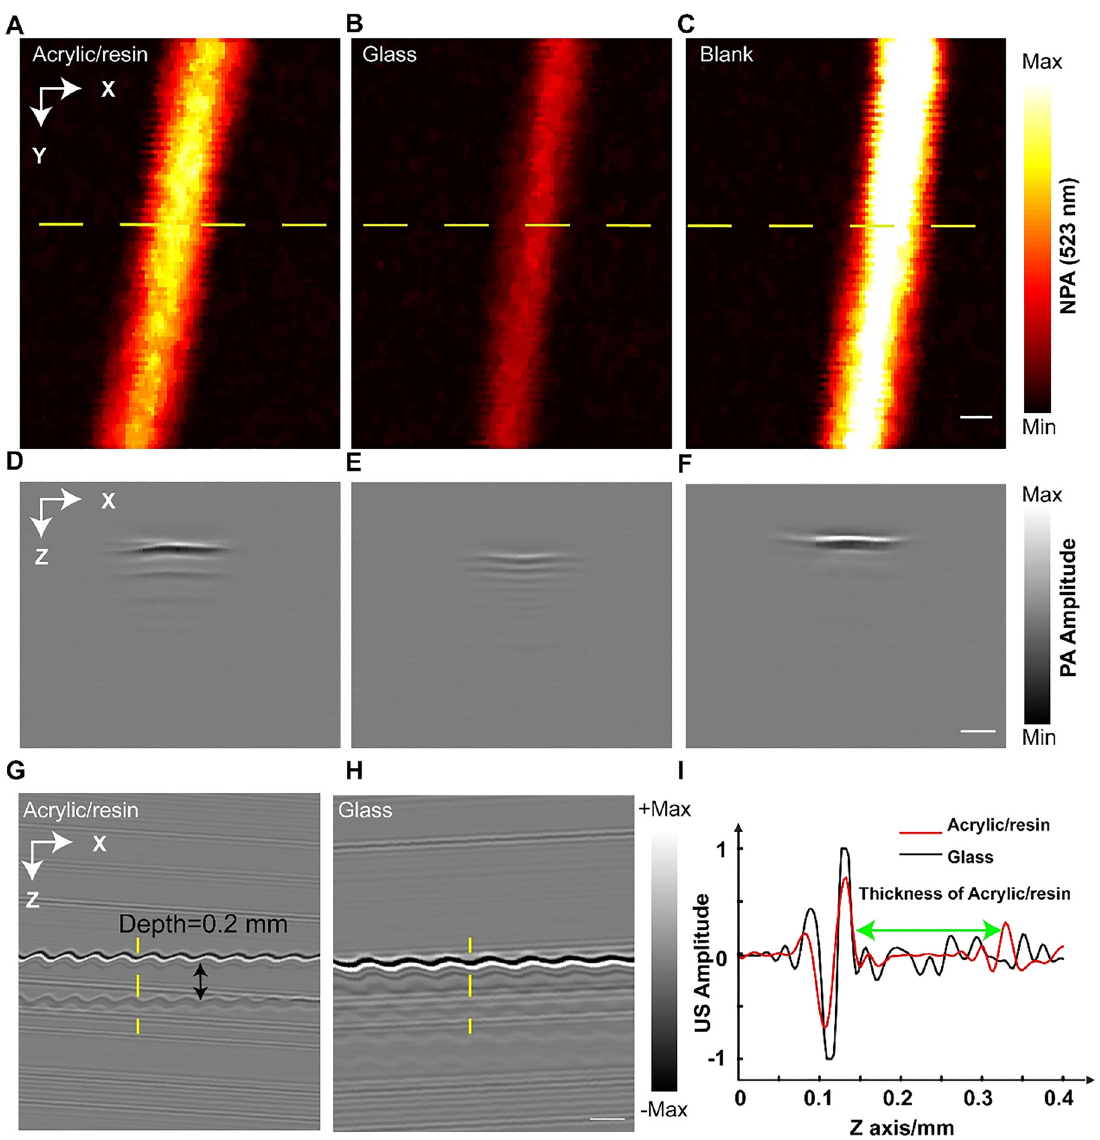
Figure 4: The photoacoustic imaging and ultrasound imaging of acrylic/resin and glass coverslips. (A – C) Photoacoustic maximum amplitude projection (MAP) imaging of a hair covered by the acrylic/resin and glass coverslips. NPA represented normalizedphotoacoustic. Scale bar:100 µm.(D – F) Cross-sectional images in the XZ plane corresponding to positionsindicated by the yellow dashed lines in A – C. Scale bar: 200 µm. (G – H) Ultrasonic cross-sectional images of the acrylic/resin and glass coverslips in the XZ plane. (I) Ultrasonic signal pro fi le through the yellow dashed lines in G – H. Scale bar: 200